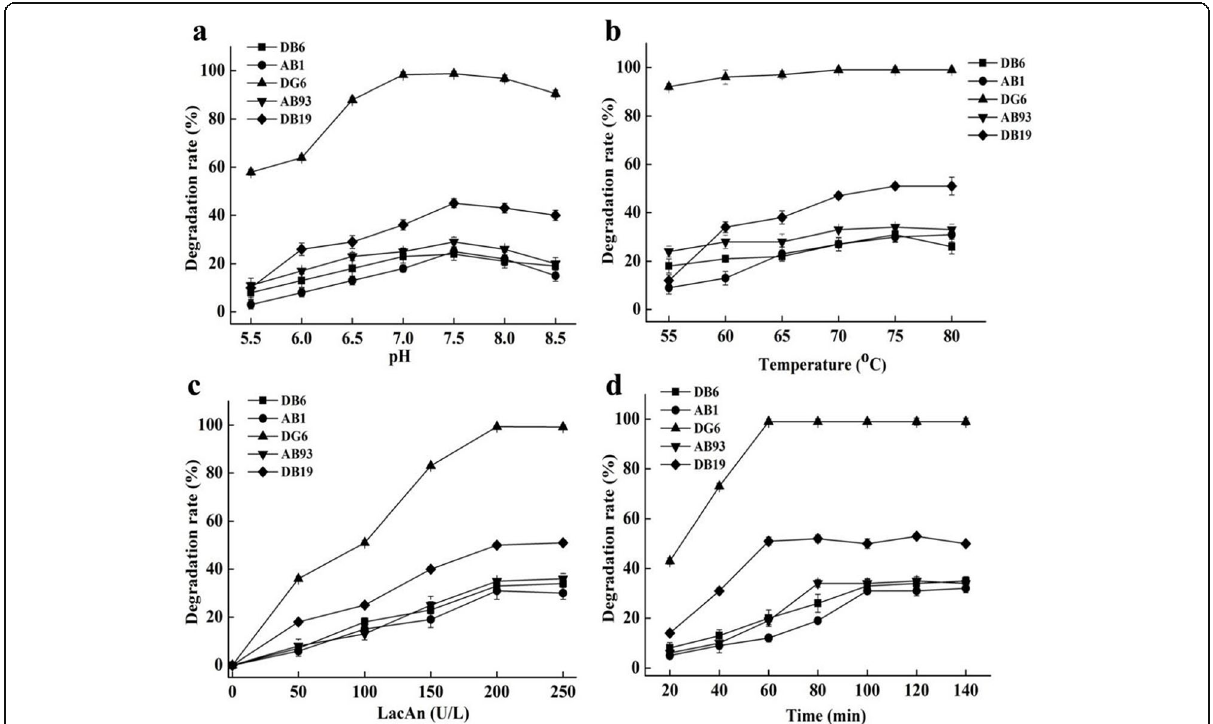
Fig. 5 Effect of pH ( a ), temperature ( b ), concentration of LacAn ( c ), and time ( d ) on the decolorization rate of LacAn oxidation dyes. The values